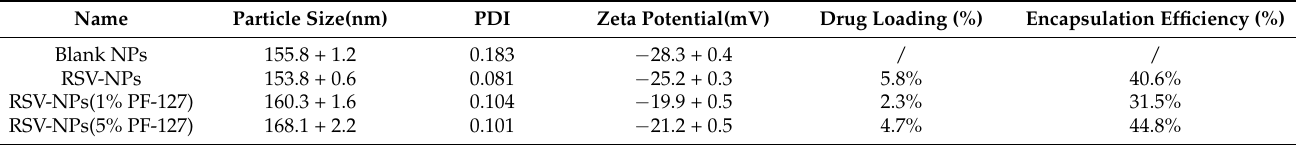
Table 1. Characteristic of NPs (mean ± S.E.M., n =